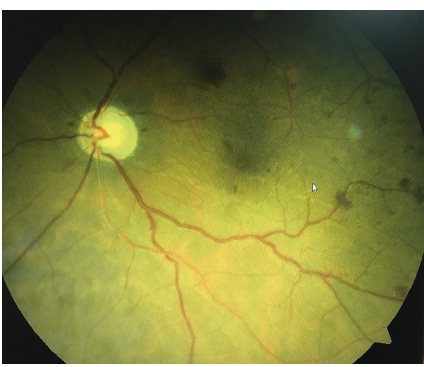
Figure 2: Fundus examination showing scattered retinal hemor- rhages in the periphery and posterior pole typical for de- compression retinopathy.